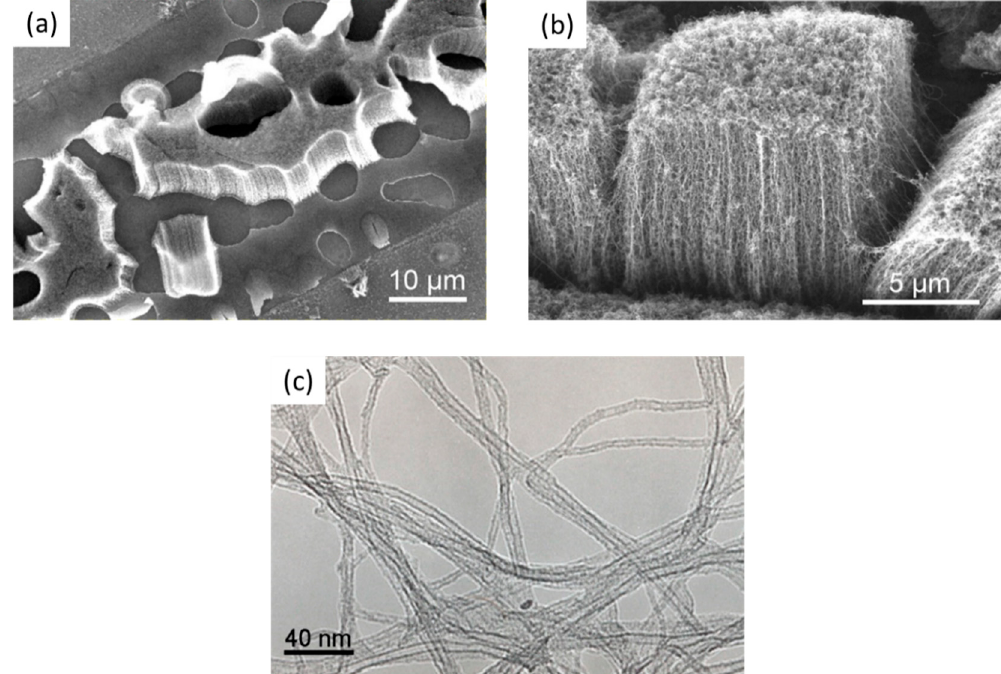
Figure 10. SEM micrographs of ( a ) the Si/TiN patterned substrate after the AC-CVD synthesis where ( b ) is the corresponding magnification of a growth zone of VACNT; ( c ) TEM image of SWCNT selectively grown on TiN surface. Modified after [88].